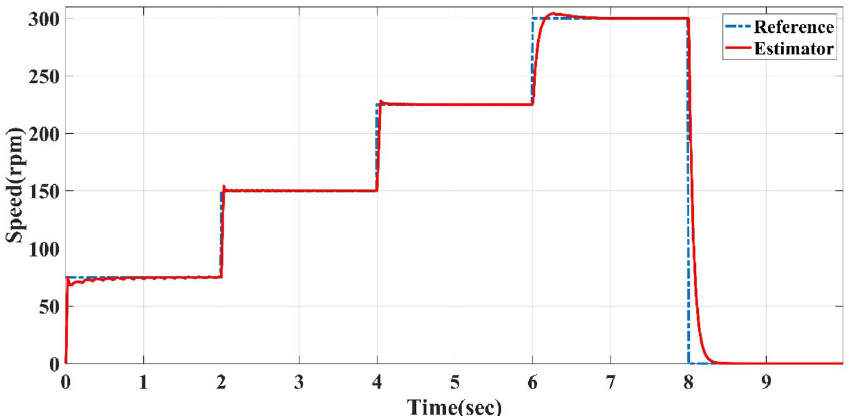
Figure 7. Reference speed cycle at 2-s interval and straight-line guided by reference speed sensorless estimator of AFPMSM.